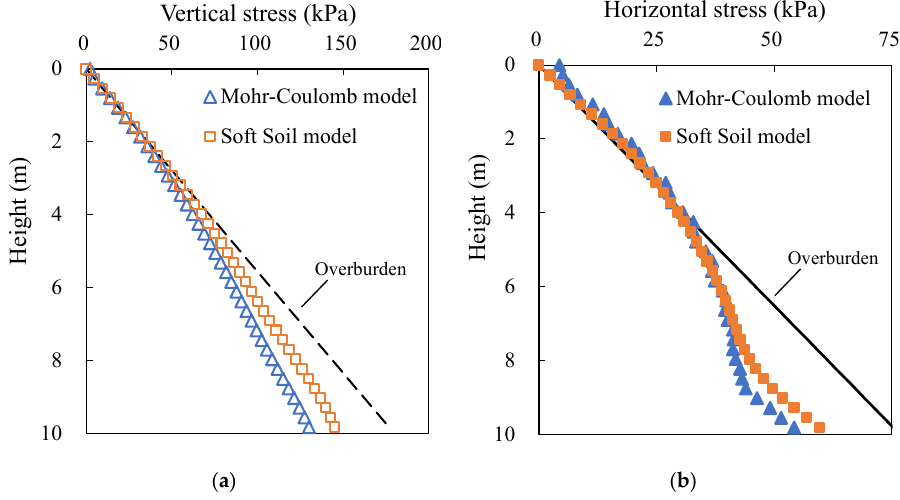
Figure 13. Variation of the ( a ) vertical and ( b ) horizontal stresses along the VCL of overlying back ‐ filled stope before the underlying extraction.